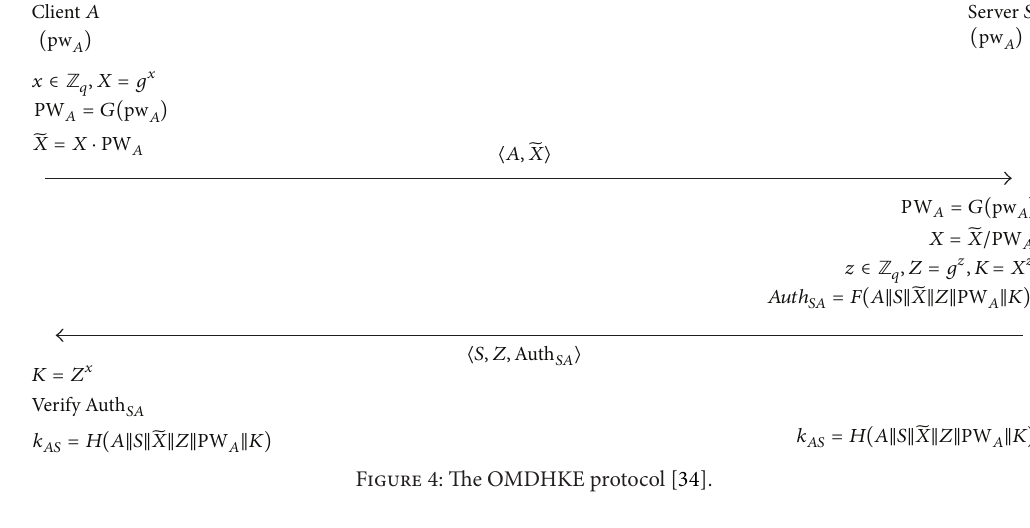
Figure 4: The OMDHKE protocol